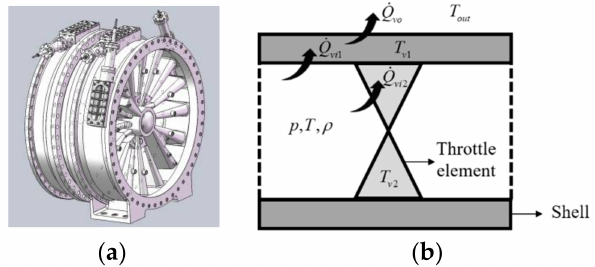
Figure 4. Regulating valve and its heat transfer process. ( a ) Regulating valve; ( b ) Heat transfer process.